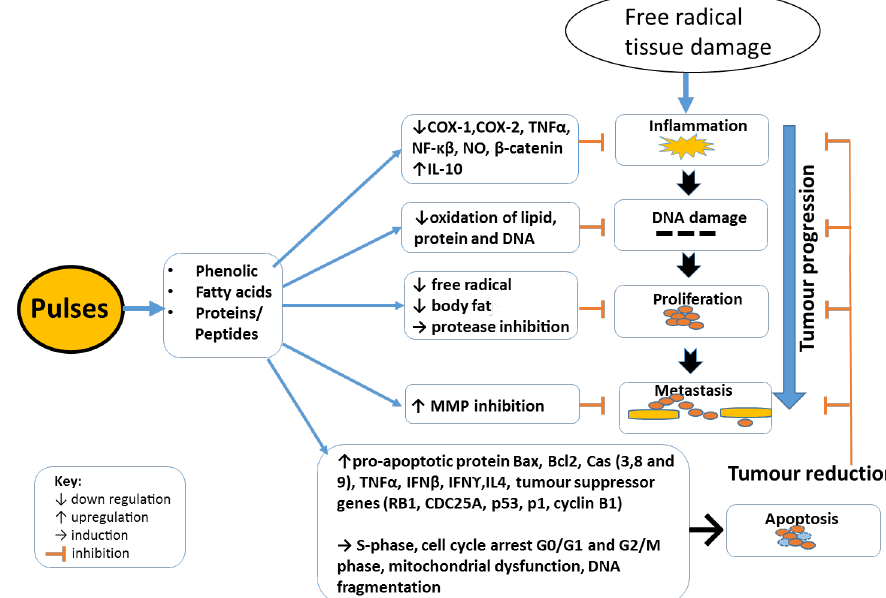
Figure 2. Potential interaction of pulse bioactive compounds with cancer pathways. Cyclooxygenase (COX), tumour necrosis factor α (TNFα), nuclear factor kappa β (NF-κβ), interleukin (IL), interferon (IFN), (LOX), nitric oxide (NO), matrix metalloproteinase inhibitors (MMPI).